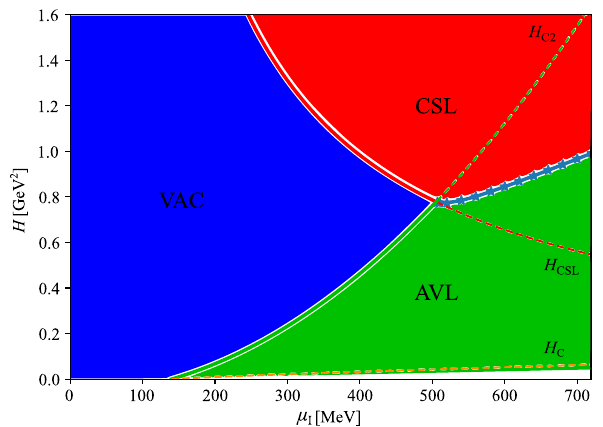
Fig. 5 Competition of the CSL phase and the Abrikosov vortex lattice phase for a low pion mass, m π = ef π ≈ 27 . 9 MeV. The top curve indicates the upper critical field H c2 . The bottom curve corresponds to thefield H CSL ,atwhichtheCSLstatebecomesfavoredoverthevacuum. The actual phase transition between the vortex lattice and CSL phases is indicated by the middle curve with data